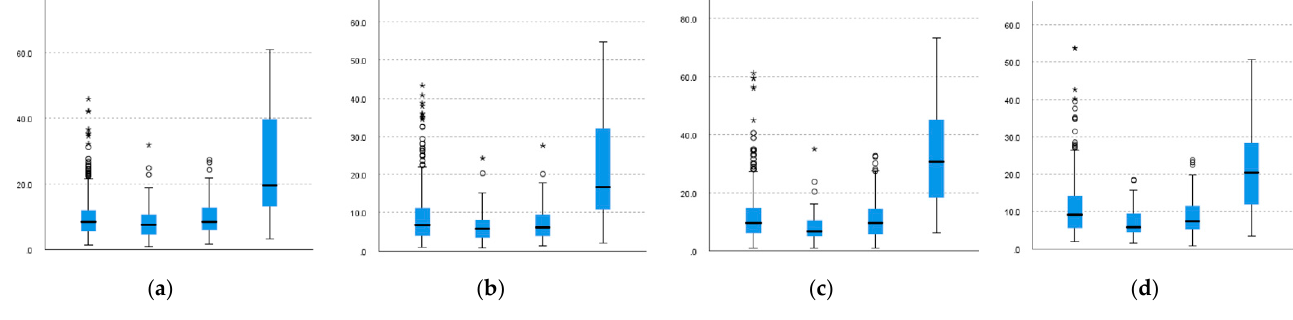
Figure 9. Comparison of lower-body joint angle variation. ( a ) VRknee. ( b ) VRankle. ( c ) VLknee. ( d ) VLankle. Table 8. Post hoc testing of lower-body joints.